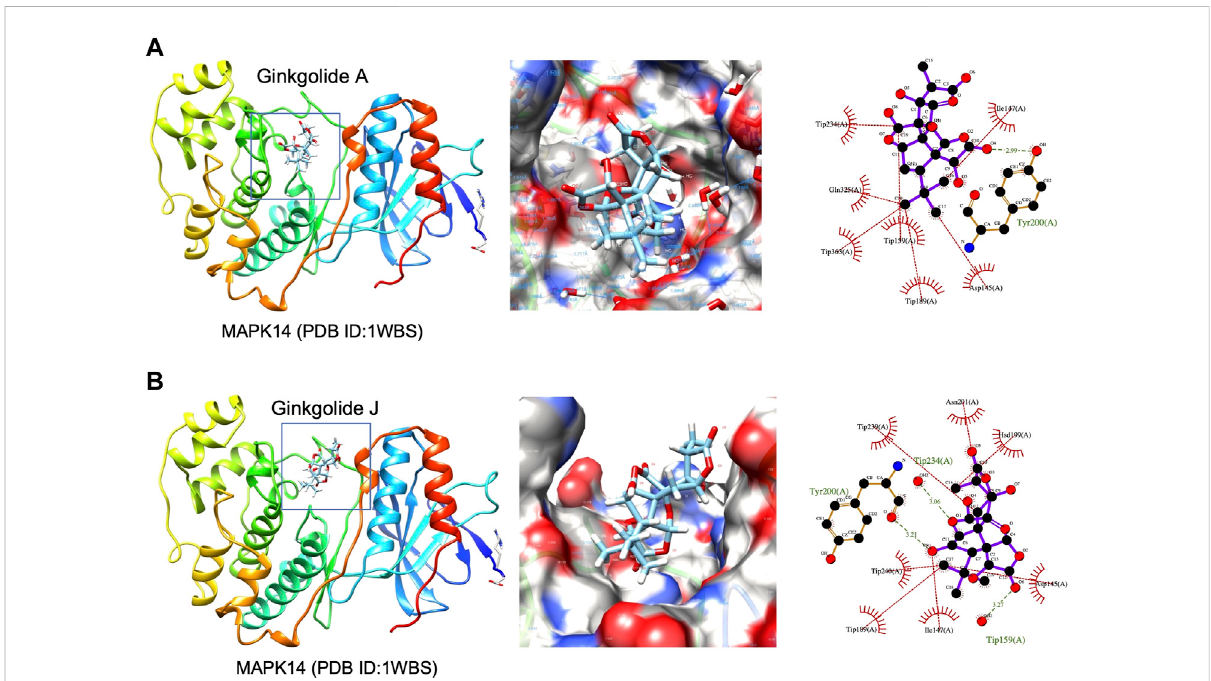
FIGURE 7 3D structures of MAPK14 docked with ginkgolide A or ginkgolide J. (A) Docking of ginkgolide A to MAPK14(PDB ID:1WBS). Left: 3D structure represented of ginkgolide A docked to MAPK14. Middle: Surface representation of ginkgolide A docked to MAPK14. Right: Protein-ligand interaction visualized by Ligplot. (B) Docking of ginkgolide J to MAPK14(PDB ID:1WBS). Left: 3D structure represented of ginkgolide J docked to MAPK14. Right: Surface representation of ginkgolide J docked to MAPK14. Right: Protein-ligand interaction visualized by